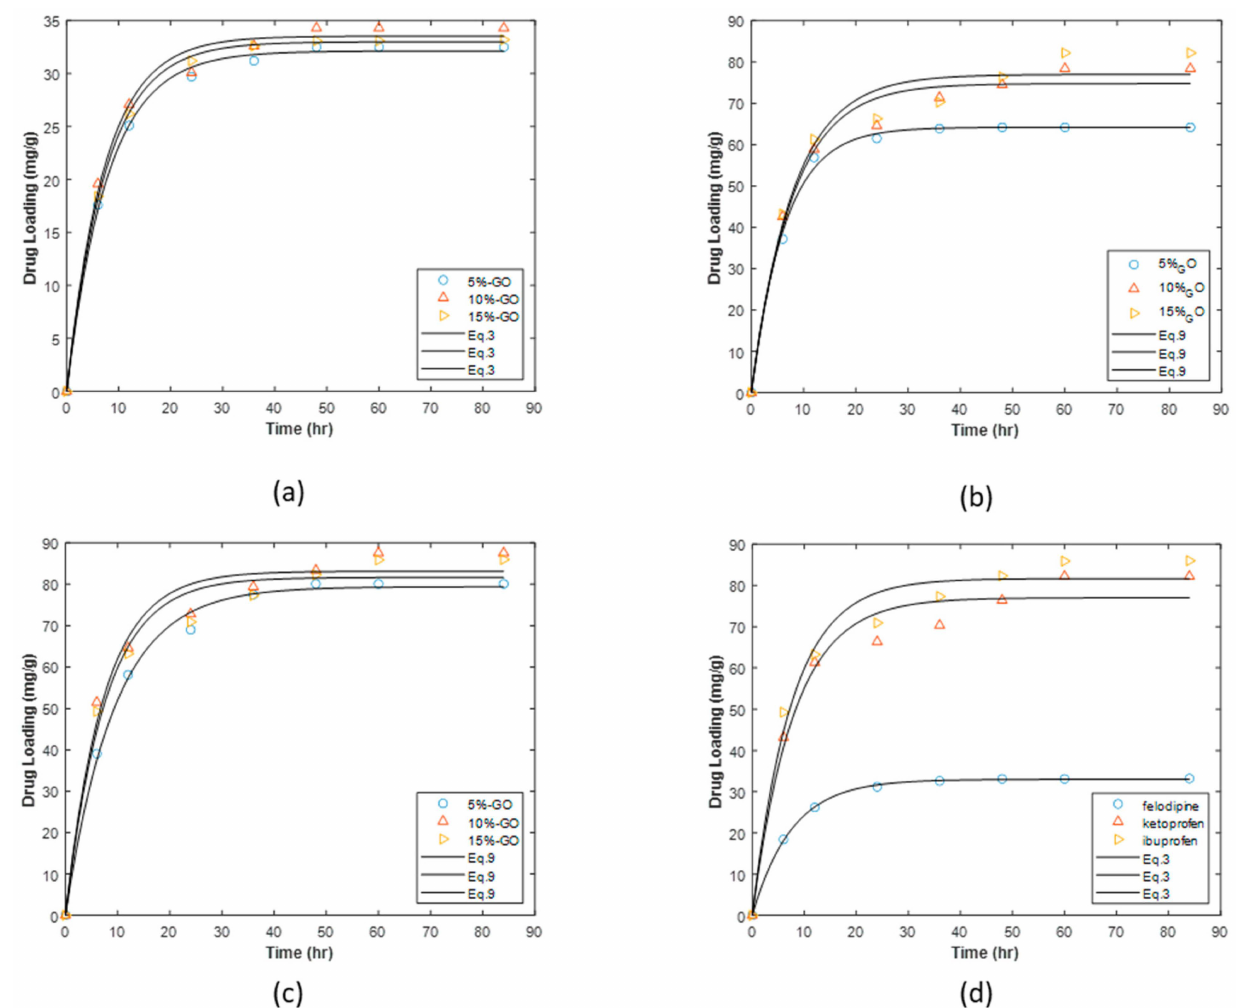
Figure 7. Loading kinetics of drugs onto HKUST-1/GO composite materials: ( a ) felodipine ( b ) keto- profen ( c ) ibuprofen ( d ) comparison of the three drugs for the HKUST-10% GO